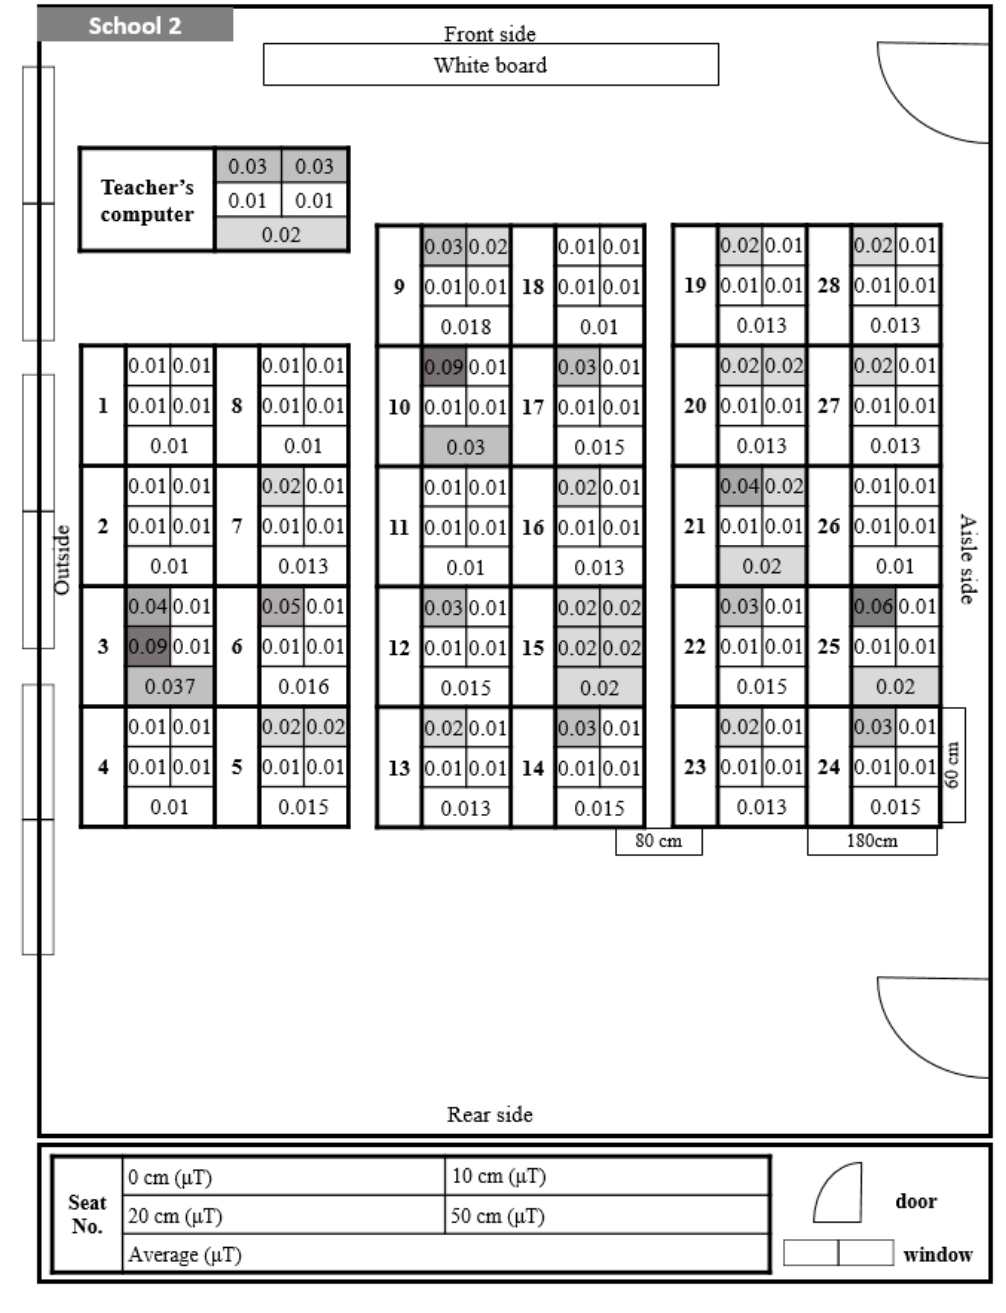
Figure 3. Distribution and exposure level of extremely low-frequency magnetic fields at each student seat in School 2. 0.01 is the lowest readout level, indicating < 0.01. The darkening of the space indicates that the level of ELF-MFs exposure increase by 0.01.